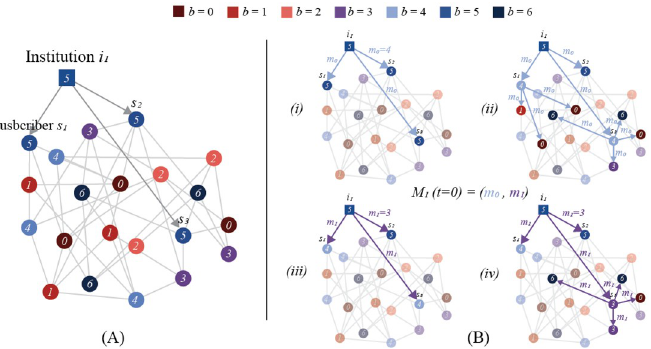
Fig 2. A graphical illustration of one time step of the POD model. In the left panel, (A) depicts the initial setup of a small network with institutional agent i 1 with subscribers s 1 , s 2 , s 3 . All agents in the network are labeled with their belief strength. The right panel, (B) depicts one time step t = 0 of agent i 1 sending messages M 1 ( t = 0) = ( m 0 , m 1 ). ( i ) shows the initial sending of m 0 = 4 to subscribers, and ( ii ) shows s 1 and s 3 believing the message and propagating it to their neighbors. ( iii ) and ( iv ) show the same for m 1 = 3, but only s 3 believes m 1 .